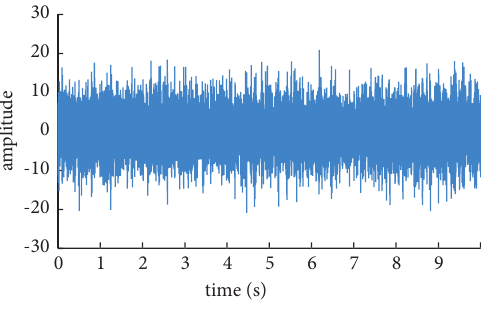
Figure 5: Dataset time domain curve.